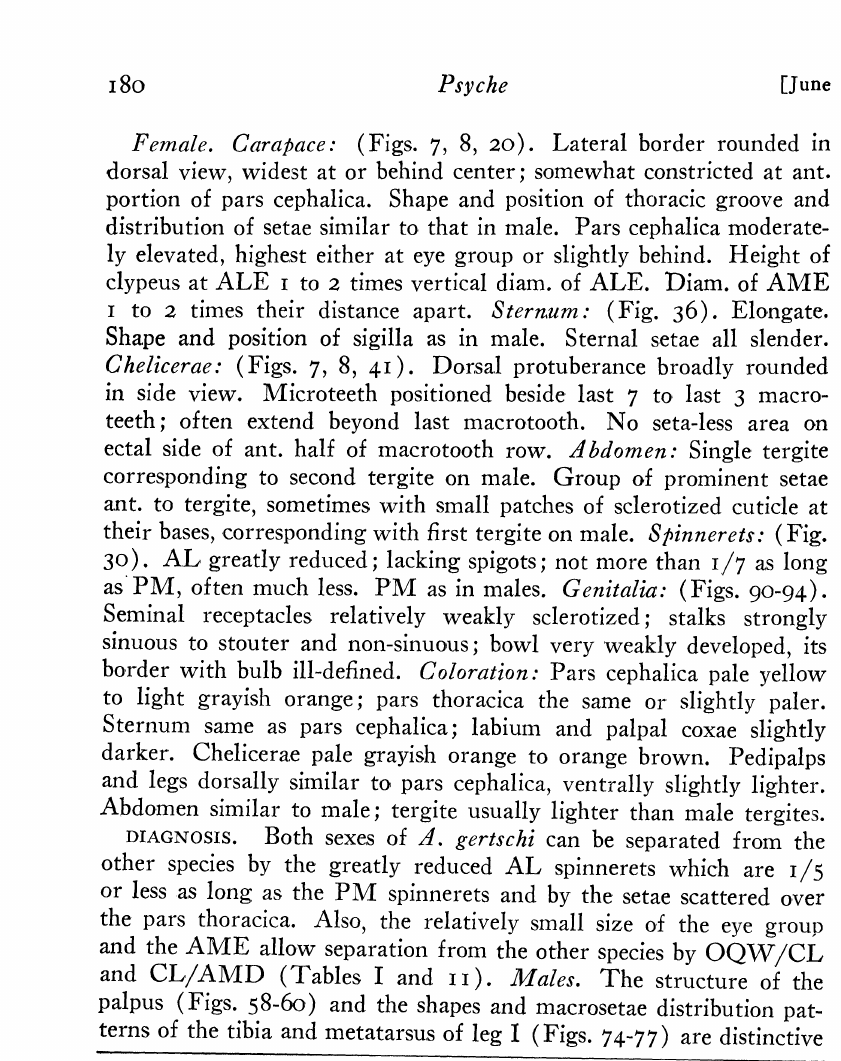
(All measurements 65. Histo-